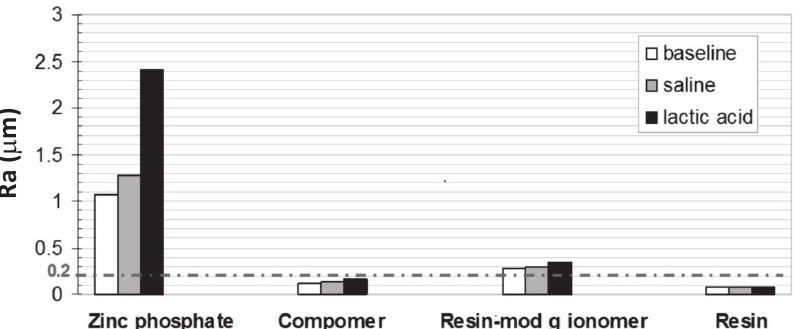
Figure 2- Comparison between the average roughness of cements and the clinical threshold (0.2 µm) for surface roughness that would be associated with higher biofilm